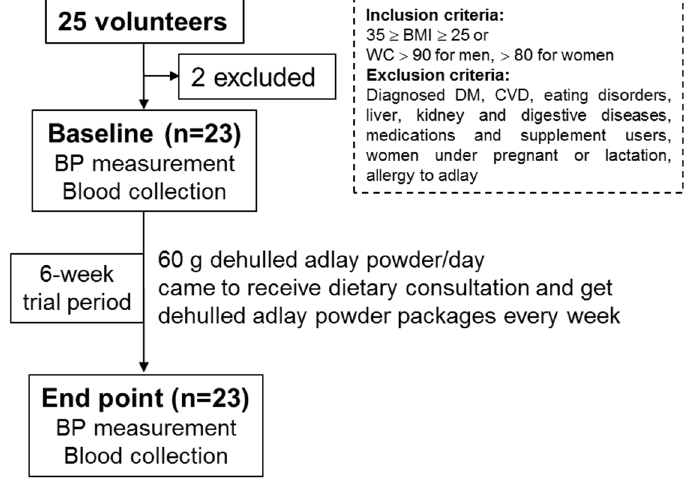
Figure 1. Flowchart illustrating the number of volunteers who were screened, included, and com- pleted the study.